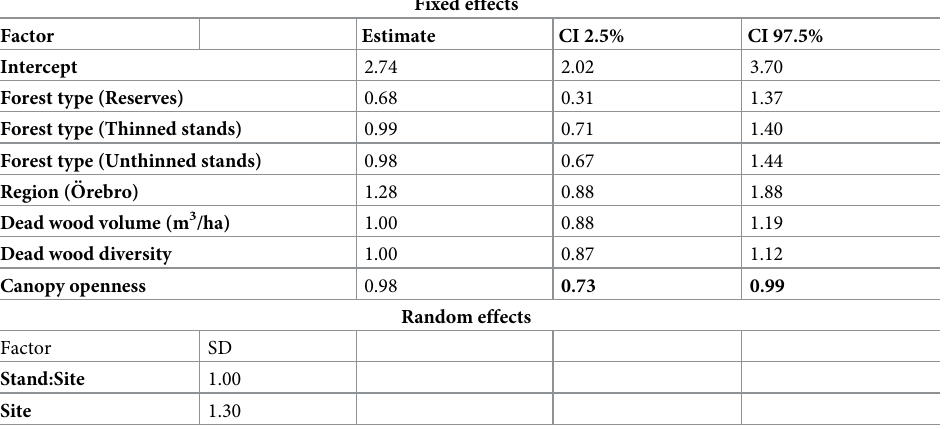
Table 4. Red-listed alpha diversity and environmental factors. GLMM results for red-listed species. For the categor- ical predictors “Forest type” and “Region”, Woodland Key Habitat (WKH) and Jo¨nko¨ping are the respective reference levels. The continuous predictors (Dead wood volume, Dead wood diversity, Canopy openness) have been unstandard- ized and all values have been back-transformed, giving odds ratios for the fixed effect estimates. The random factor “Stand” is nested within “Site”. Confidence intervals (CI) not overlapping 1 (indicating statistical significance) have been marked in